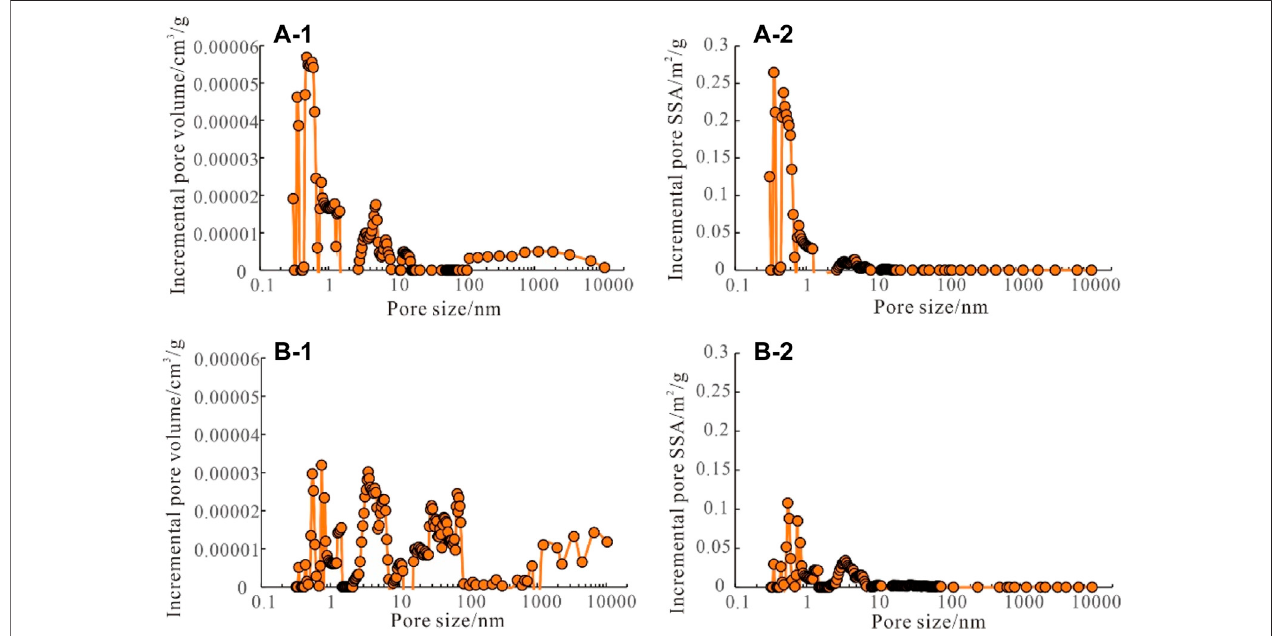
FIGURE 10 | Distribution of pore volume and pore SSA over pore size of OM (A-1,A-2) and clay minerals (B-1,B-2) of Shan 23 shale.